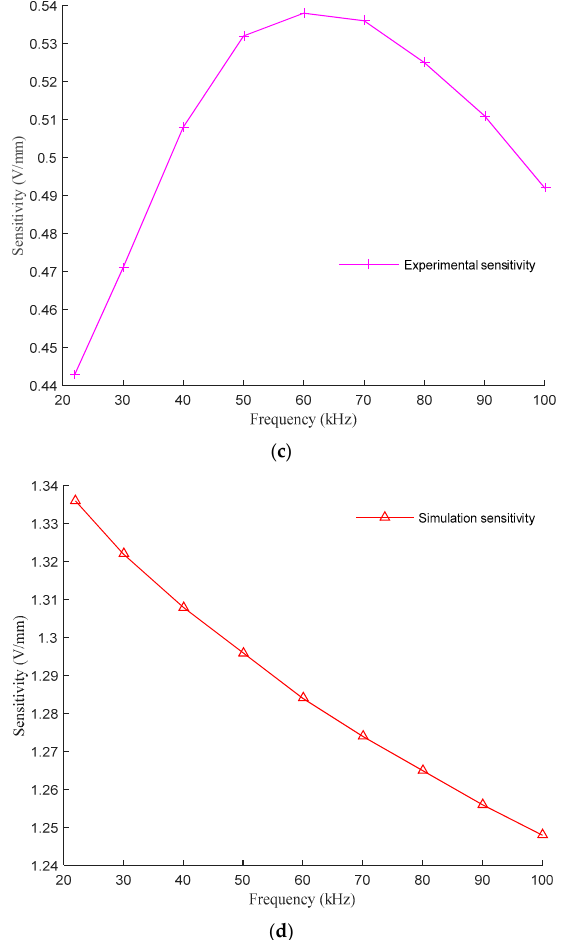
Figure 15. Variation of experimental sensitivity, simulation sensitivity and theoretical sensitivity with frequency. ( a ) Variation of sensitivity with frequency; ( b ) Variation of theoretical sensitivity considering core eddy current with frequency; ( c ) Variation of experimental sensitivity with fre- quency; ( d ) Variation of simulation sensitivity with frequency. The reason for the above differences is that only the effect of eddy current on core permeability is considered in the process of establishing the theoretical model. The rela- tive permeability μ r in formula (9) is a real number estimated based on the B-H curve of silicon steel. However, in practice, the hysteresis effect will also affect the relative perme- ability μ r [30,31]. Therefore, when deriving the relationship between the real and imagi- nary parts of the core relative complex permeability, the selection of a = 1 is estimated on the premise of considering only the eddy current. According to the comparison of theo- retical and simulation results, there will be certain errors when choosing the theoretical model with a = 1. At the same time, the sensor structure designed in the laboratory is miniaturized, with a magnetic pole width of only 8 mm and a thickness of 4 mm. The